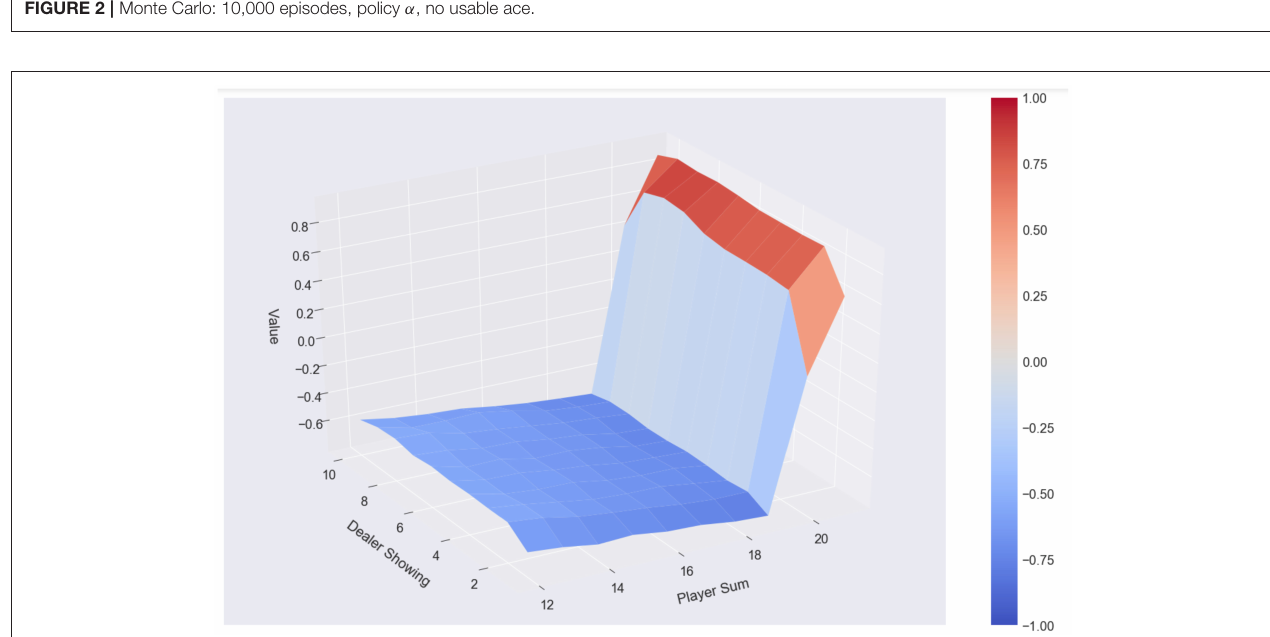
FIGURE 2 | Monte Carlo: 10,000 episodes, policy α , no usable ace.